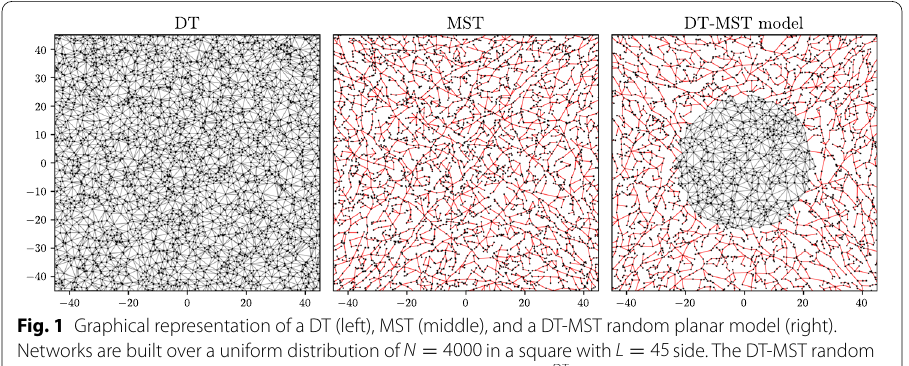
Fig. 1 Graphical representation of a DT (left), MST (middle), and a DT‑MST random planar model (right). Networks are built over a uniform distribution of N = 4000 in a square with L = 45 side. The DT‑MST random planar model is obtained by keeping the DT in a circle with radius R DT = 24 , and the MST